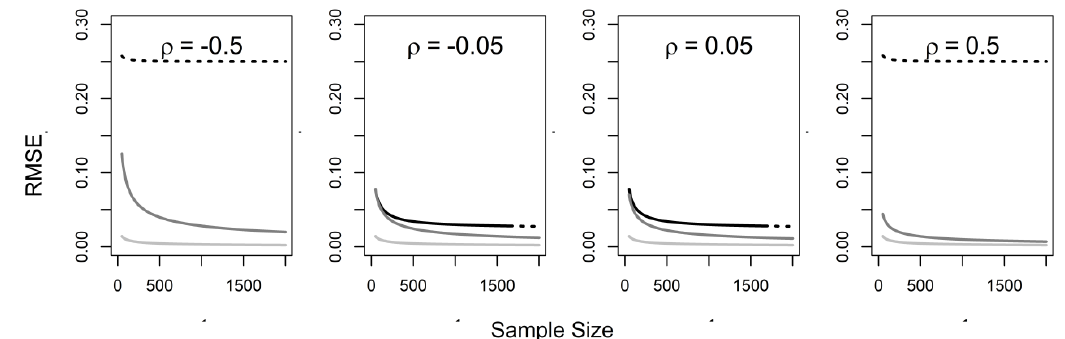
Figure 2. The root mean squared error (RMSE) as function of sample size in analysis ( n ) with duration of exposure (black), duration of exposure adjusted for distribution of intensity (grey), and cumulative exposure (light grey); dotted lines indicate that 95% confidence internal coverage is less than 50%. NB: correlation of intensity and duration varies by panel (ρ), ratio of variances of intensity and duration (k = 1), and strength of causal effect (β 1 = 0.5). Int. J. Environ. Res. Public Health 2019 , 16 , x